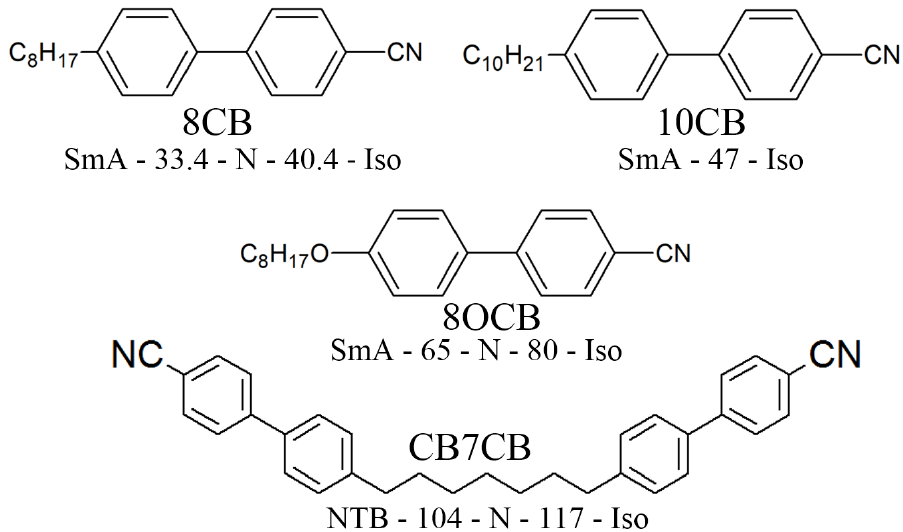
Figure 1. Chemical structure and phase transition temperatures (°C) of 4 ′ -Octyl-4-biphenylcarbonitrile (8CB), 4 ′ -Decyl-4-biphenylcarbonitrile (10CB), 4 ′ -(Octyloxy)-4-biphenylcarbonitrile (8OCB) and [4 ′ ,4 ′ -(heptane-1,7-diyl)bis(([1 ′ ,1 ″ -biphenyl]4 ″ -carbo-nitrile))] (CB7CB) liquid crystals.